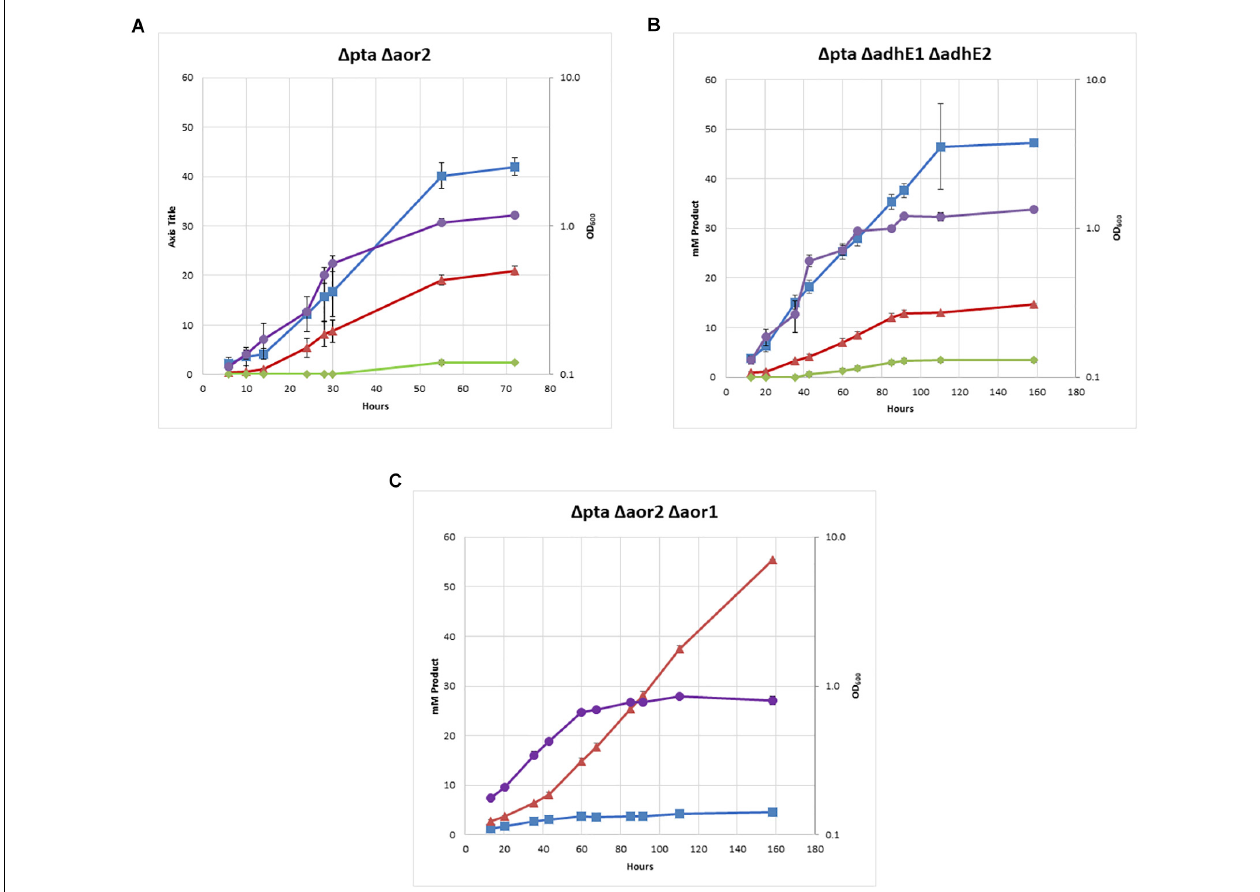
FIGURE 4 | Heterotrophic growth and fermentation products of strains on PETC with 5 g/L fructose. Acetate in blue squares, ethanol in red triangles, 2,3-butanediol in green diamonds, OD 600 in purple circles. (A) (cid:49) pta (cid:49) aor2, (B) (cid:49) pta (cid:49) adhE1 (cid:49) adhE2, and (C) (cid:49) pta (cid:49) aor2 (cid:49)